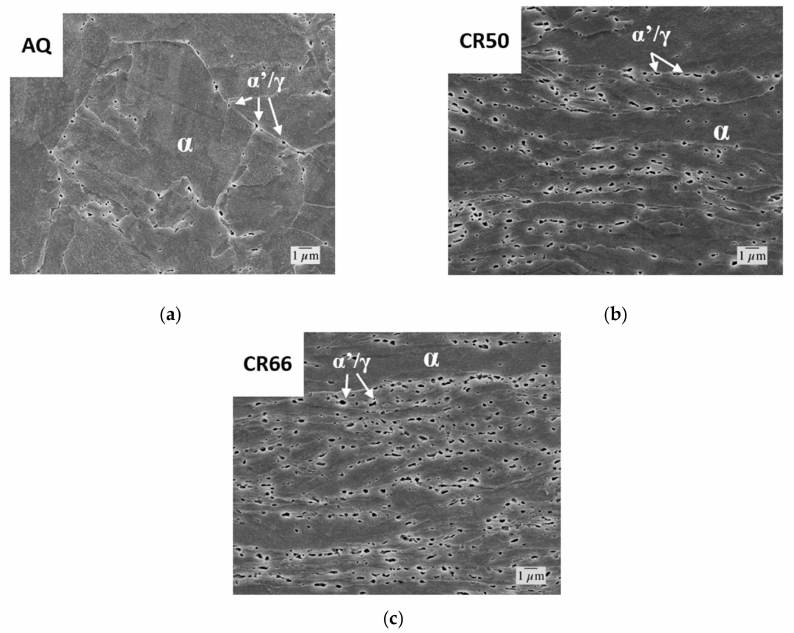
Figure 7. FESEM images of the ( a ) as-quenched (AQ), ( b ) CR50, and ( c ) CR66 conditions after heating to 500 ◦ C at 12 ◦ C / s and isothermal holding for 10,000 s followed by quenching to 30 ◦ C at 100 ◦ C / s. Regions of martensite (previously austenite) are labeled α ’ / γ . Regions of ferrite are labeled α . One pct Nital Etch.